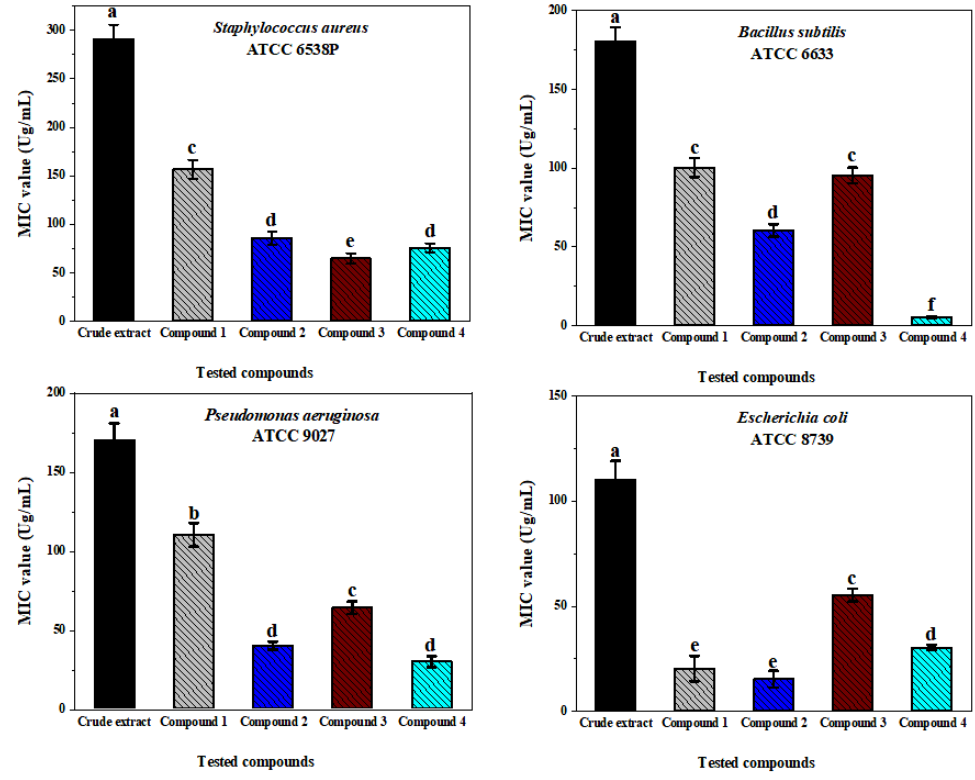
Figure 5. The minimal inhibitory concentration (MIC) of fungal crude extract and its pure compounds against the tested bacterial strains.